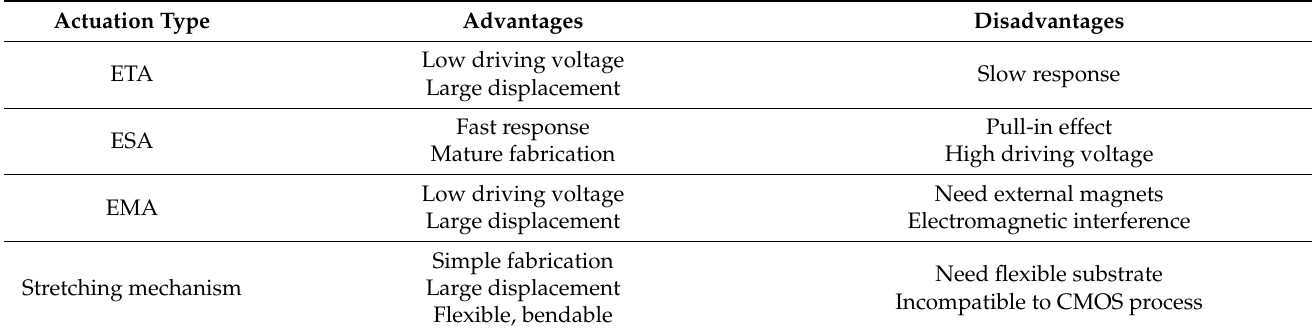
Table 1. Comparison of MEMS-based tuning mechanism.